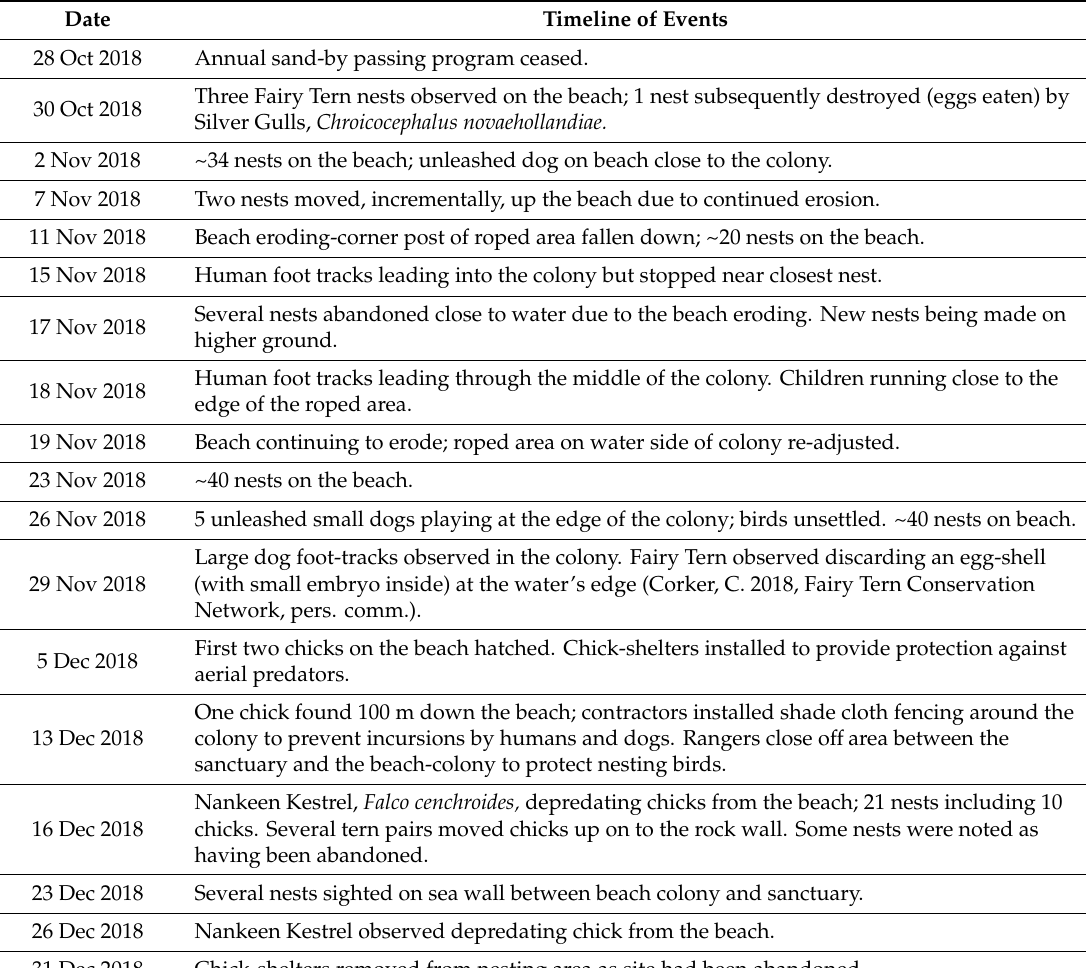
Table 3. Timeline showing the development of the beach-nesting colony at Mandurah, disturbance and predation events, and management activities undertaken during the 2018–2019 breeding